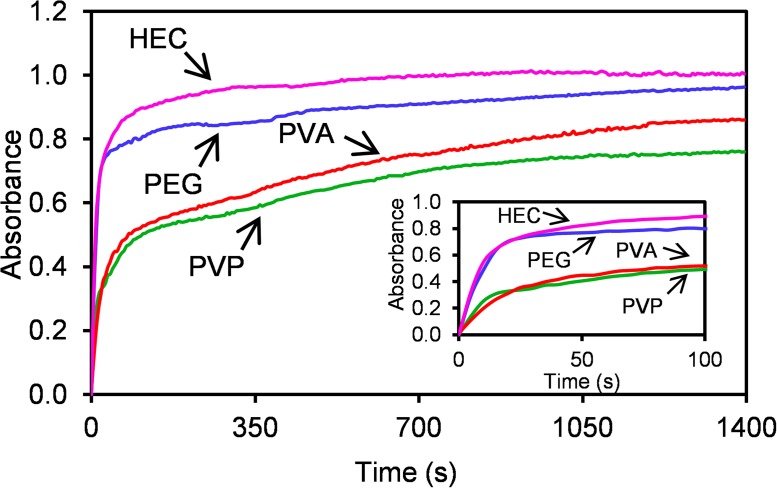
Kinetic curves for AgBr nanoparticles reduction by NaBH4 in the presence of studied polymers (λmax represent position of absorption maxima) and zoom of the first 60 seconds (inset).